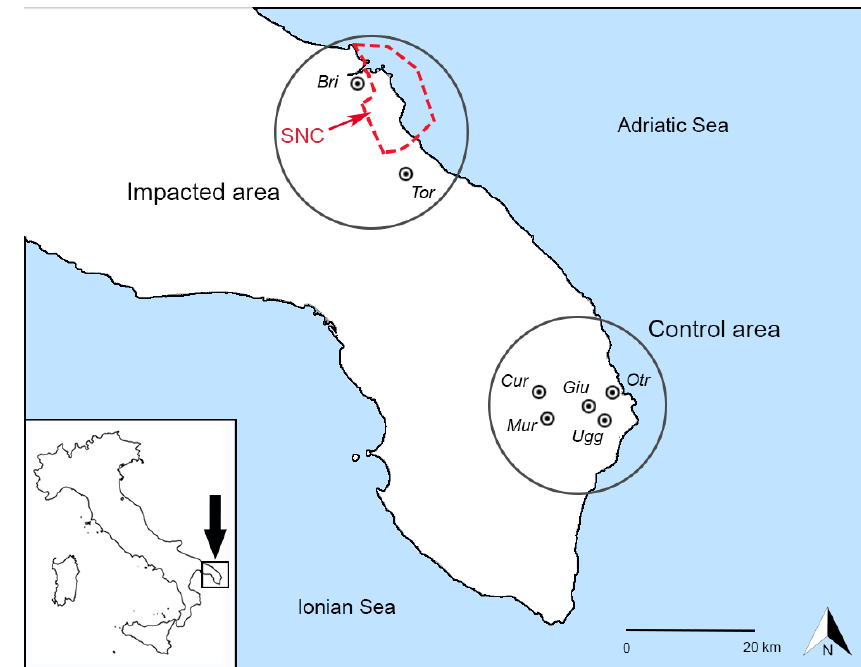
Figure 1. Map of the study area (SNC: Site of National Concern; Bri: Brindisi; Cur: Cursi; Giu: Giurdignano; Mur: Muro Leccese; Otr: Otranto; Tor: Torchiarolo; Ugg: Uggiano La Chiesa).